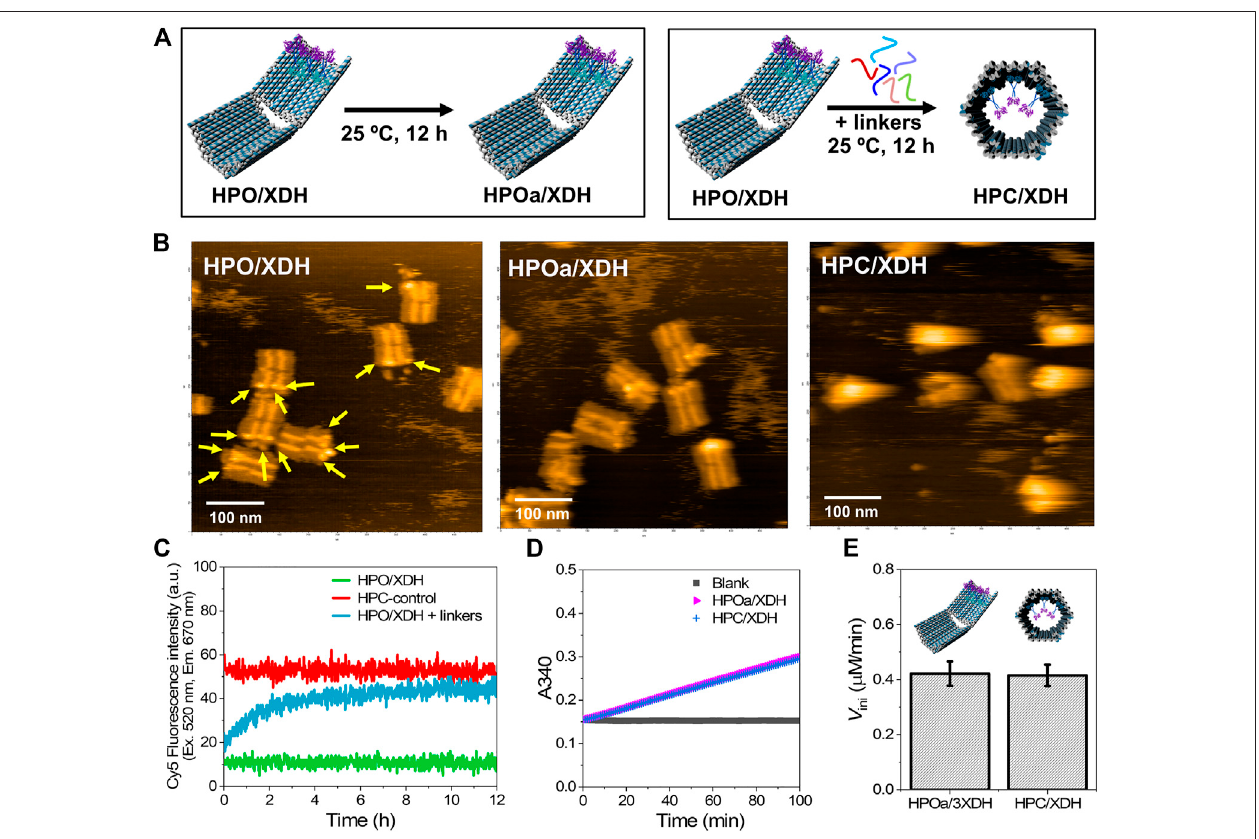
FIGURE 5 | Xylitol dehydrogenase (XDH) encapsulated in HPC maintained its catalytic activity. (A) Schemes representing the sample incubation or hybridization with the closing keys of DNA scaffolded HG-XDH. HPO/XDH was incubated in the absence or presence of closing linkers at 25 ° C for 12 h to obtain a control sample for XDH assembled on the open state (HPOa/XDH) or encapsulated in the closed state (HPC/XDH). (B) Typical AFM images of HPO/XDH (left), HPOa/XDH (middle), and HPC/XDH (right); scale bar: 100 nm. The yellow arrows indicated the immobilized enzyme HG-XDH. (C) Time course changes of the Cy5 fl uorescence intensity ( λ ex (cid:2) 520 nm, λ em (cid:2) 670 nm)fortheHPO/XDHclosingprocess.Hybridizationconditions:1.5 nMHPO/XDH(scaffoldconcentration)washybridizedwith1.5 nMclosing linkers in the buffer (pH 7.0) containing 40 mM Tris-HCl, 20 mM acetic acid, 12.5 mM MgCl 2 , 0.002% Tween20, and 5 µM BSA at 25 ° C for 12 h. (D) Time course changesoftheabsorbanceat340 nm(A340)fortheenzymereactionsofHPOa/XDHandHPC/XDH.2 nMHG-XDH(dimer)werereactedwith2 mMNAD + and300 mM xylitol in the buffer (pH 7.0) containing 40 mM Tris-HCl, 20 mM acetic acid, 12.5 mM MgCl 2 , 5 μ M BSA, 1 µM ZnCl 2 , 100 mM NaCl, and 0.002% Tween20 at 25 ° C. (E) Comparison of the initial reaction velocities of HPOa/XDH and HPC/XDH (D) .